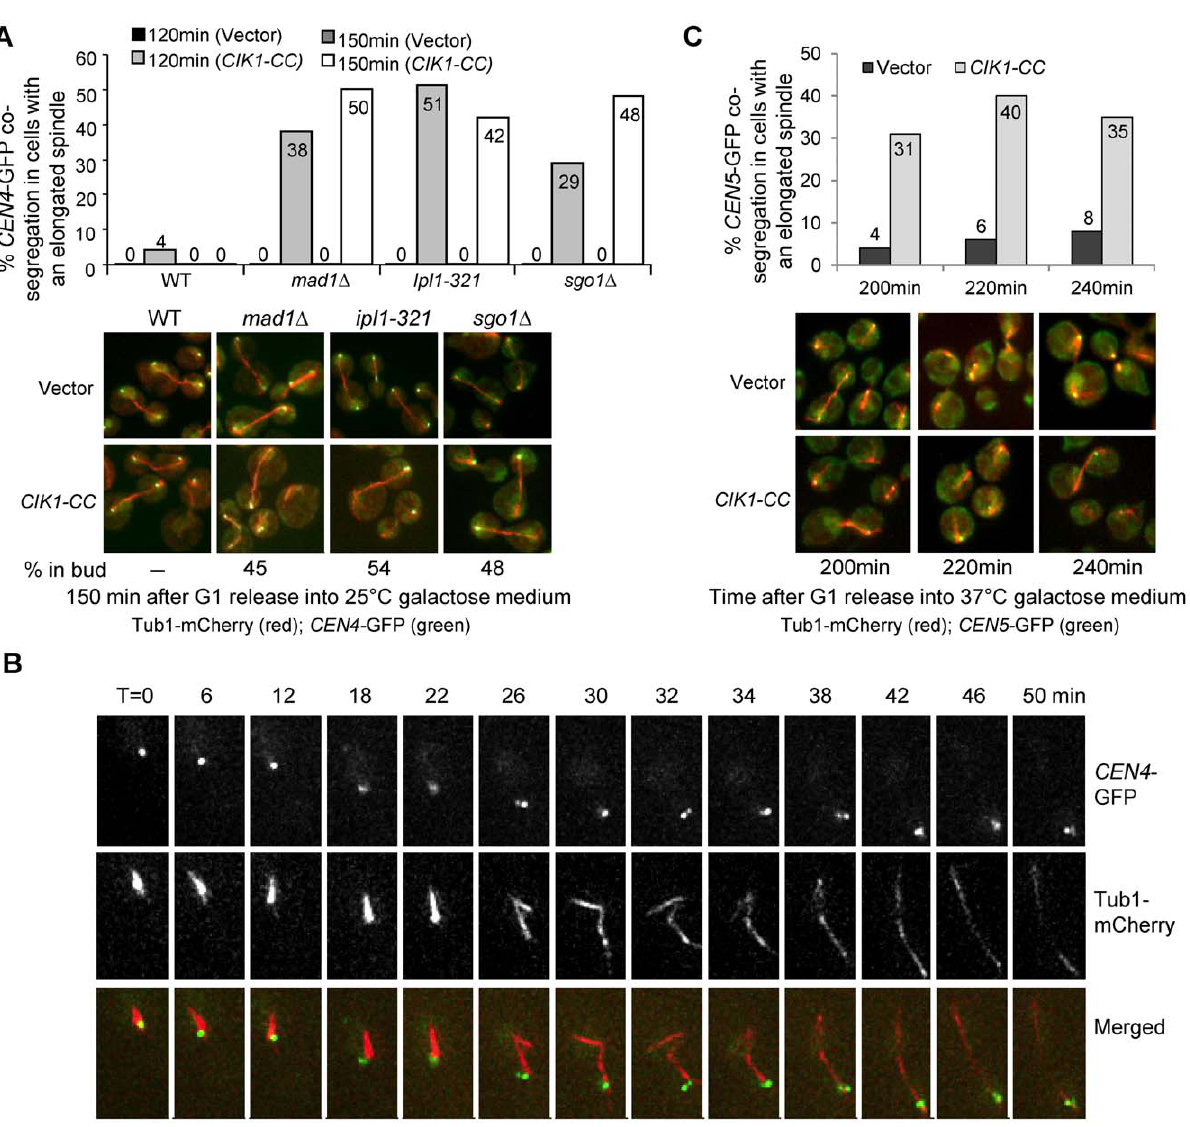
Figure 4. Overexpression of CIK1-CC results in syntelic attachment. A. Mutants in the spindle or the tension checkpoint lead to chromosome mis-segregation in cells overexpressing CIK1-CC . A vector or a P GAL CIK1-CC plasmid was introduced into WT, mad1 D , ipl1-321 , and sgo1 D cells with CEN4-GFP TUB1-mCherry . The transformants were first arrested in G 1 phase and then released into galactose medium at 25 u C. Cells were collected at 120 and 150 min and fixed for the examination of fluorescence signals. The percentage of cells with mis-segregated sister CEN4 -GFPs among those with an elongated spindle is shown in the upper panel (n . 100). The localization of CEN4 -GFP as well as spindle morphology in some representative cells is shown in the bottom panel. The numbers at the bottom of the images represent the percentage of cells that show GFP signal in the daughter cell among all of those with mis-segregated CEN4 -GFP (n . 100). B. Live-cell image of the segregation of CEN4 -GFP in a sgo1 D cell overexpressing CIK1- CC . sgo1 D CEN4-GFP TUB1-mCherry cells with vectors or P GAL CIK1-CC plasmids were arrested in G 1 in raffinose medium. After release into galactose medium for 2 hr, the cells were spotted onto the surface of a slide covered with agarose medium (galactose) and subjected to live-cell microscopy. At each time point, a Z-stack with 8 planes, separated by 0.5 m m, was acquired and subsequently projected. C. The segregation of CEN5 -GFP in mcd1-1 cohesin mutant cells after CIK1-CC overexpression. mcd1-1 TUB1-mCherry CEN5-GFP with either a vector or a P GAL CIK1-CC plasmid were arrested in G 1 phase in raffinose medium at 25 u C and then released into 37 u C galactose medium. We collected cells at 200, 220, and 240 min when majority of the cells were large budded to examine the spindle morphology and the segregation of CEN5 -GFP. The percentage of CEN5 -GFP co-segregation in cells with an elongated spindle is shown on the top (n . 100). The localization of CEN5 -GFP as well as spindle morphology in some representative cells is shown at the bottom panel.